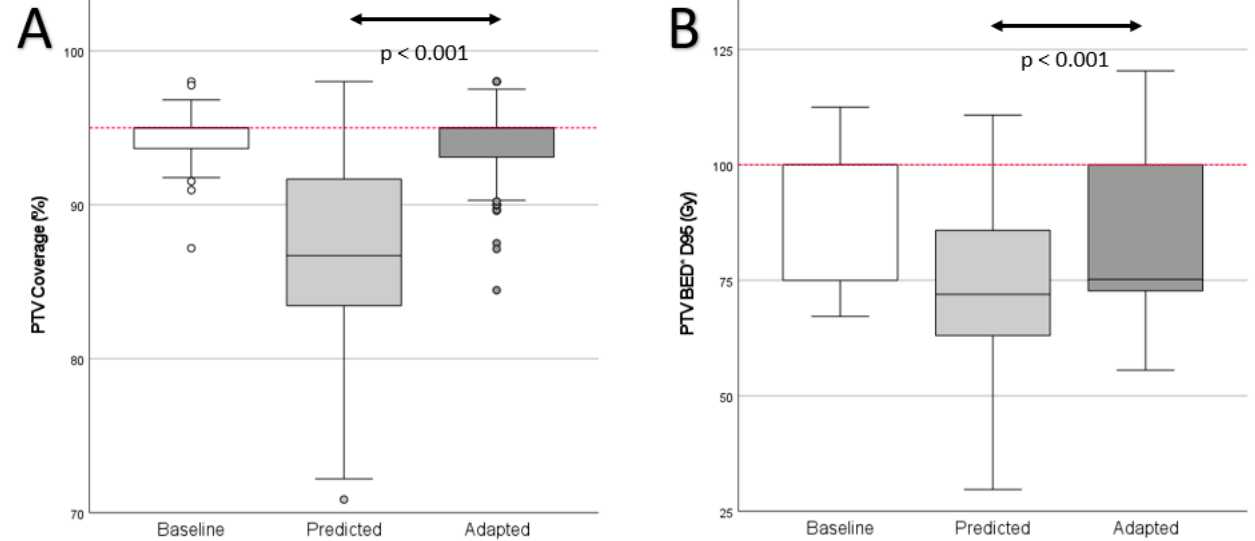
Figure 3. Planning target volume coverage (PTV) and biologically effective dose (BED). ( A ) PTV coverage. The dashed line represents the aimed 95% coverage. ( B ) BED * covering 95% of the PTV (D95). The dashed line represents 100 Gy BED. * α / β = 10 for the liver metastases. Overdosing inside the PTV was less frequent in the adapted plans (Figure 2B; predicted: 38 out of 200, 19.0%, adapted: 12 out of 200, 6.0%, p < 0.001; baseline: